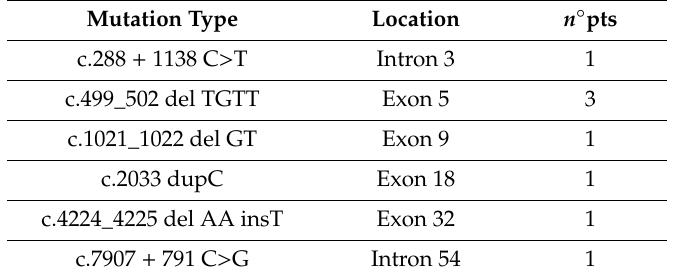
Table 2. NF1 pathogenic variants not observed by NGS and detected on RNA by